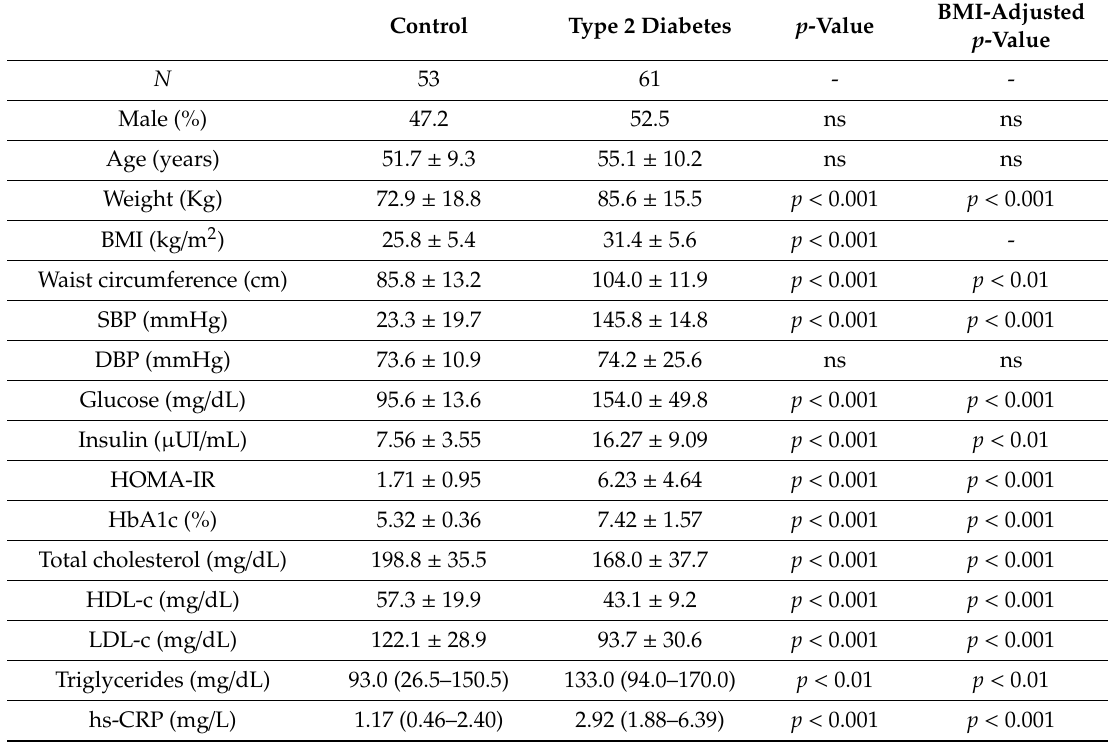
Table 2. Anthropometric and analytical